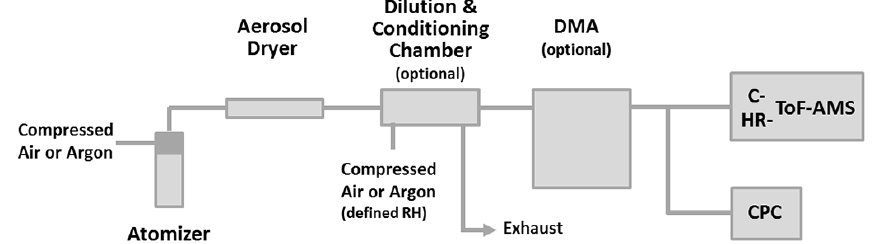
Figure 1. Setup for the measurements of non-refractory and semi-refractory aerosols with defined carrier gas humidity and with air and argon as the carrier